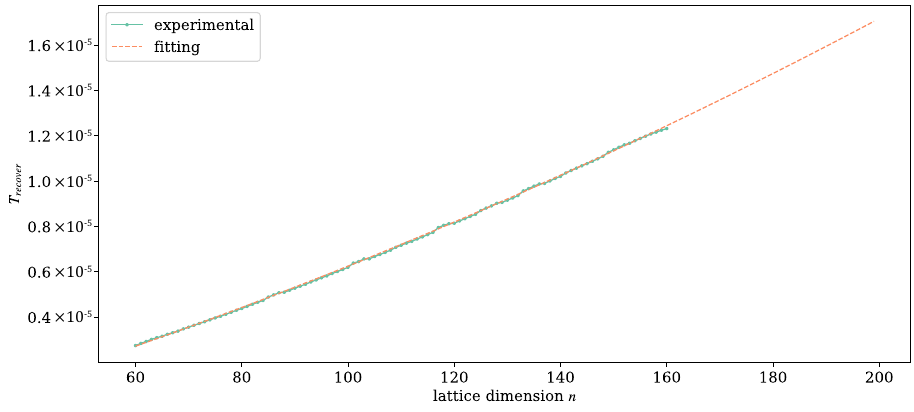
Figure 6. The relation between T decode and dimension n